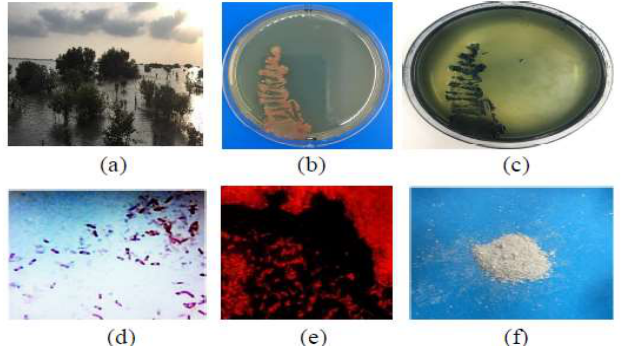
Figure 1. Screening of promising marine bacterial isolate, KKU-MD13, for poly-β-hydroxybutyrate (PHB) production. ( a ) Mangaroves in Al-Madhaya coast; ( b ) bacterial culture; ( c ) plate staining with Sudan Black-B; ( d ) slide staining with Sudan Black-B; ( e ) slide staining with Acridine orange; ( f ) powder of extracted PHB.